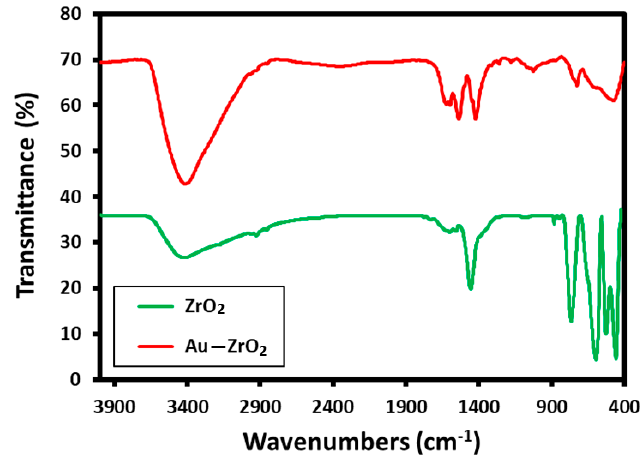
Figure 2. Comparison of the FT-IR spectra of Au-ZrO 2 with pristine ZrO 2 NPs stabilized with benzyl alcohol.